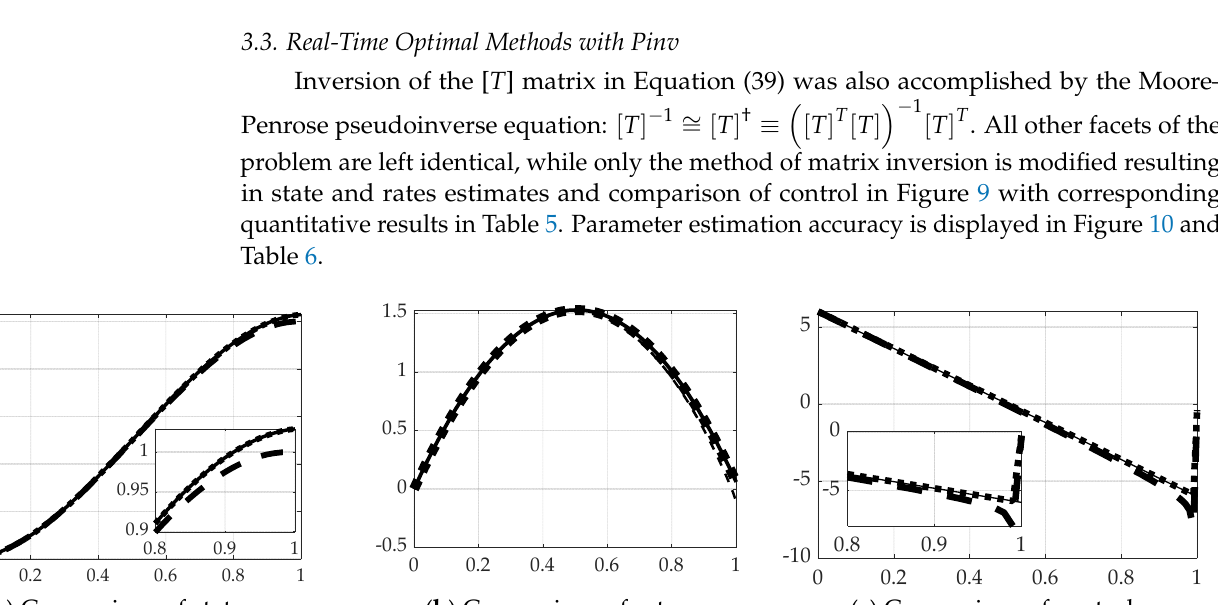
Figure 9. Comparison of real-time optimal methods with scaled time on the abscissae and respective ordinates titled in the subplot captions: solid line is open loop optimal (benchmark), dashed line is real-time optimal using backslash, thick dotted line is real-time optimal using pinv with singular switching. ( a ) States, ( b ) rates, and ( c ) decision criteria or control. The ranges of the zoomed view in the inset are indicated by the respective scales. Table 5. Comparison of real-time optimal decision methods using pinv matrix inversion.